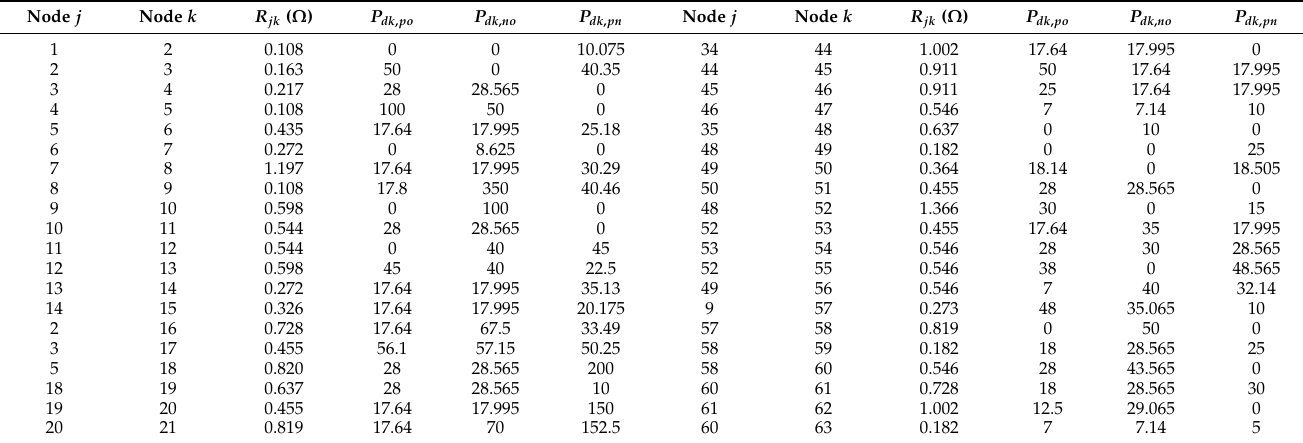
Table 2. Data for the 85-bus system (all powers in